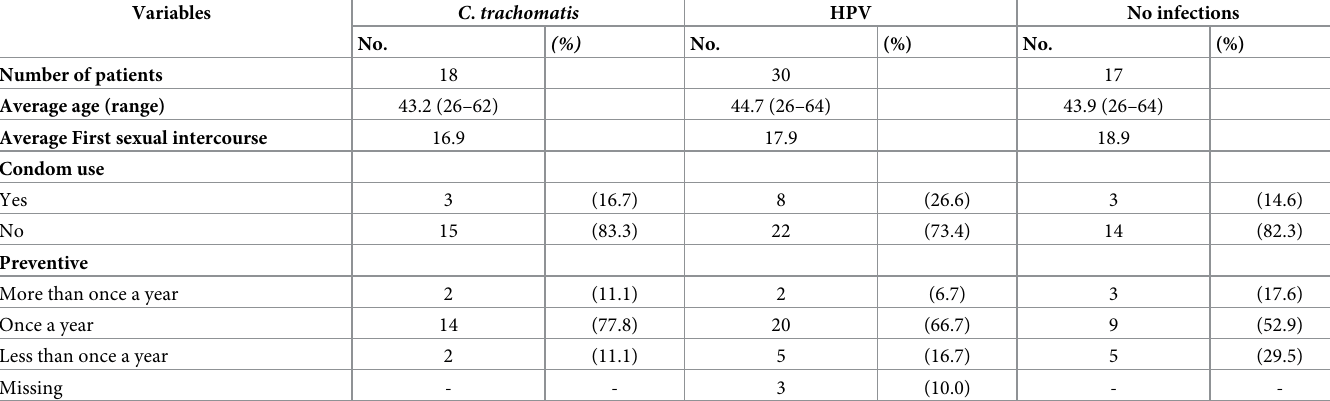
Table 1. Socioepidemiological characteristics of patients treated at the Hospital de Amor, Campo Grande, MS, Brazil. Chlamydia trachomatis DNA-positive patients (n = 18), HPV DNA positive patients (n = 30), and healthy patients (n = 17).